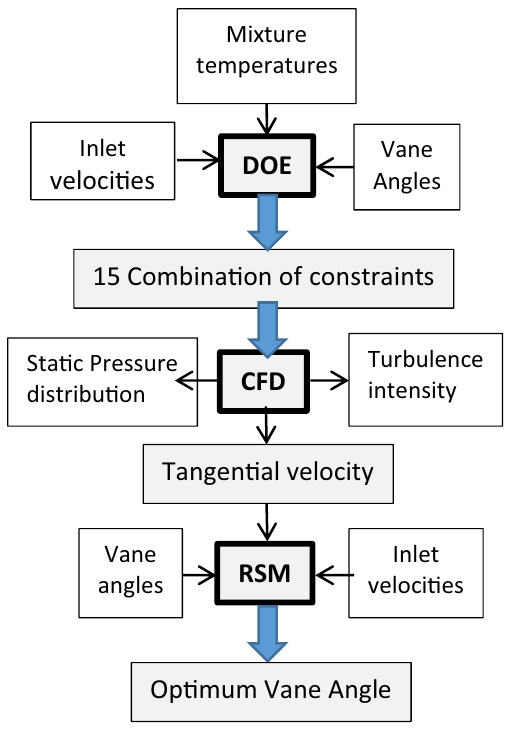
Fig. 1 Procedure of optimization methodology